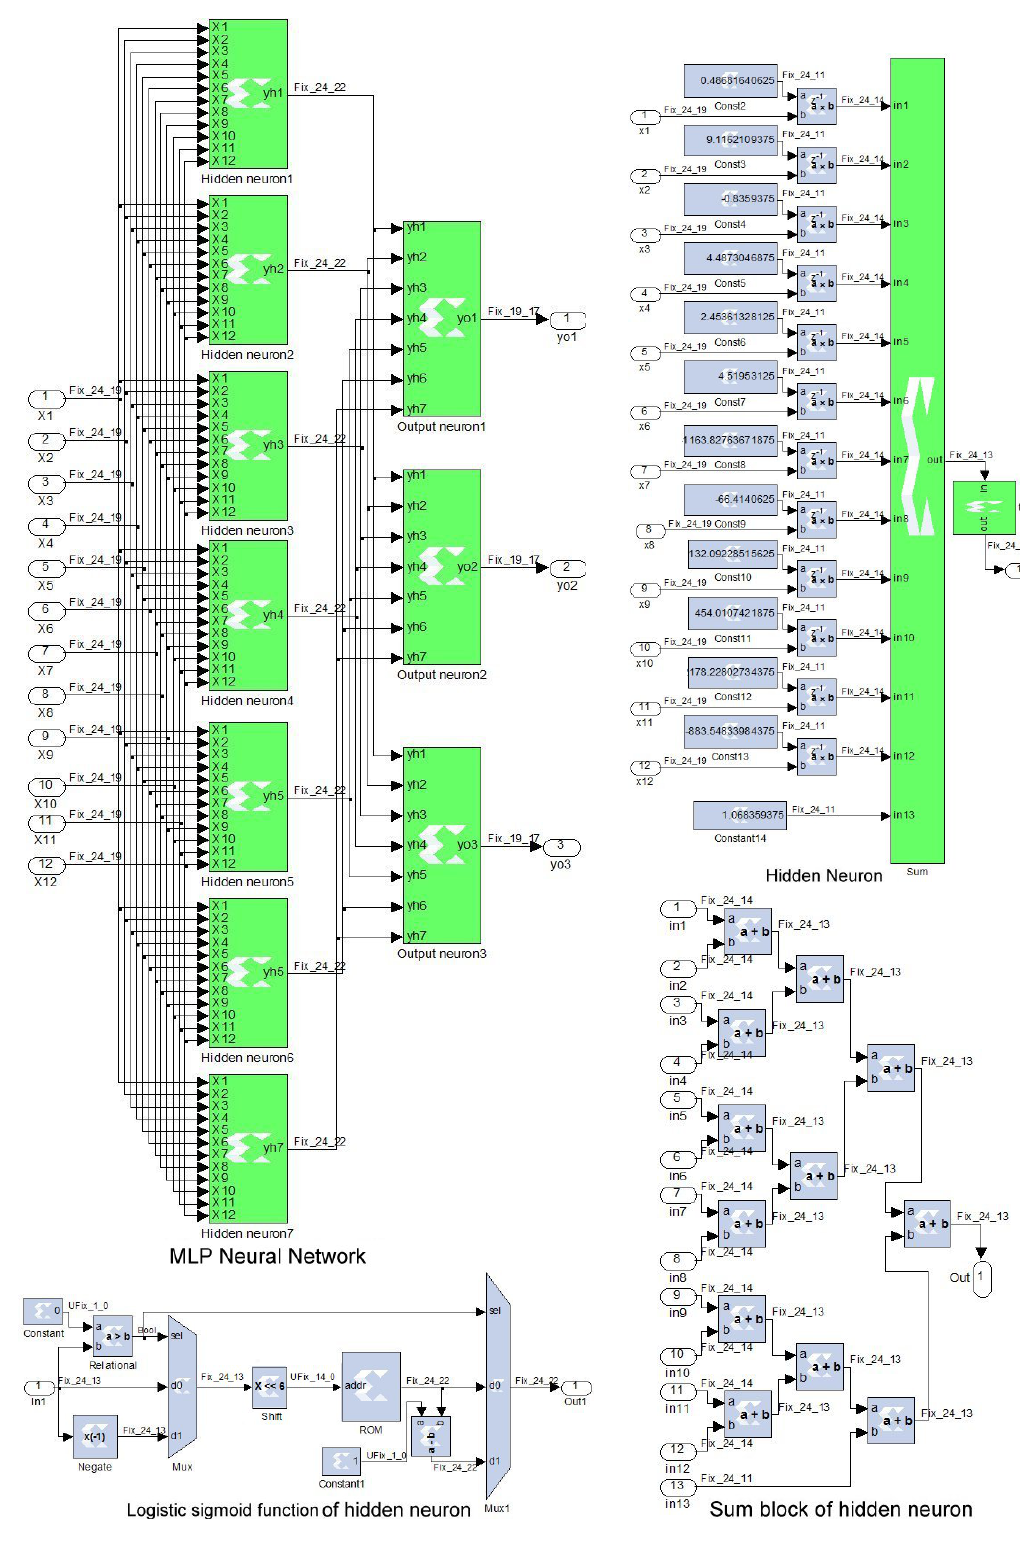
Figure 6. Architecture of the implemented MLP neural network. The hidden neuron structure, and its sum and hyperbolic tangent blocks are also